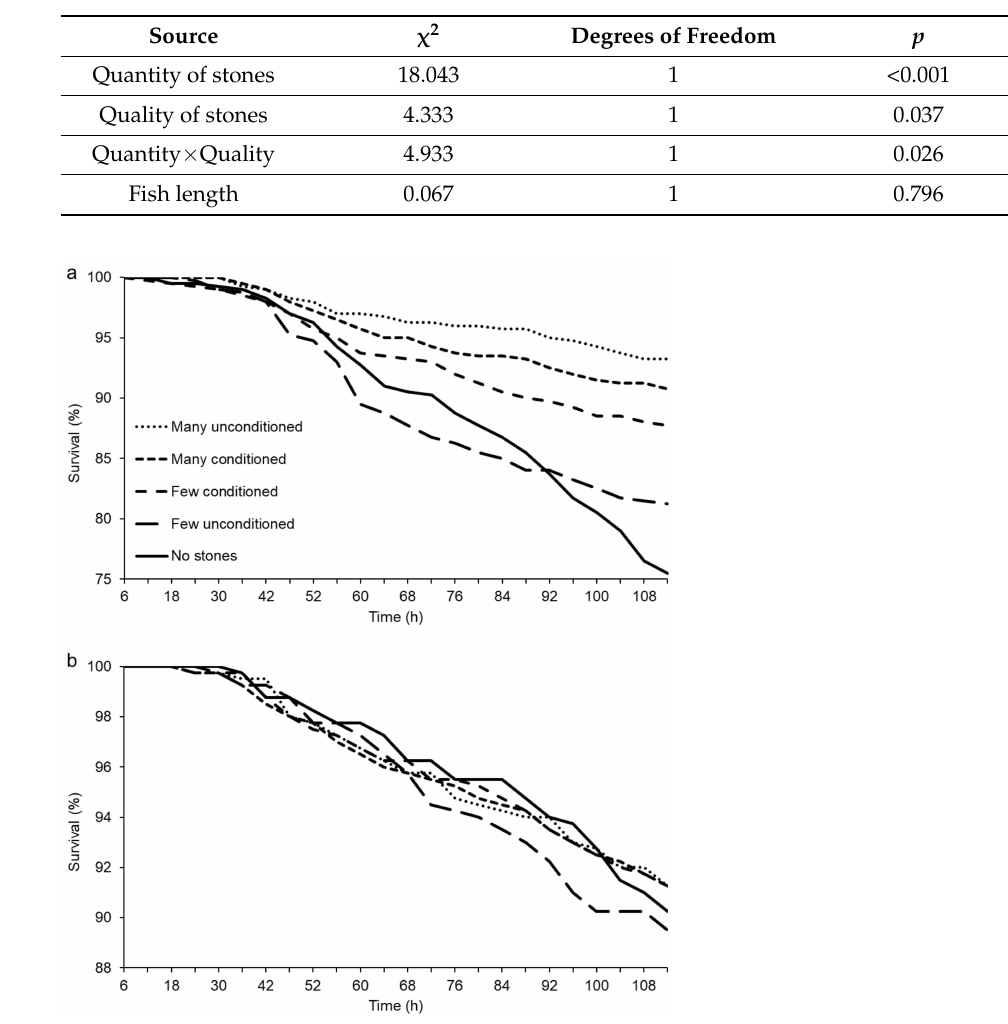
Figure 1. Survival of trout and salmon in experimental bacterial exposure. Cumulative survival curves of ( a ) sea-migrating brown trout ( Salmo trutta ) and ( b ) landlocked Atlantic salmon ( Salmo salar m. sebago ) exposed to the pathogenic bacterium Flavobacterium columnare . Exposures of groups of 100 fish took place in 50 replicated tanks (0.4 m 2 ) with different combinations of quantity (no/few (6 stones)/many (60 stones)) and quality (unconditioned/conditioned) of natural stones. Conditioning was done by keeping clean stones in the lake water before the experiment. Survival was followed every 4–6 h until 112 h post-exposure. In trout, survival was lowest in tanks without stones, but increased in the presence of conditioned stones as well as with an increasing number of unconditioned stones ( a ). Similar trends of lowest survival in tanks without stones and with few unconditioned stones were evident also in salmon at the end of the experiment ( b ). Note differences in Y axis